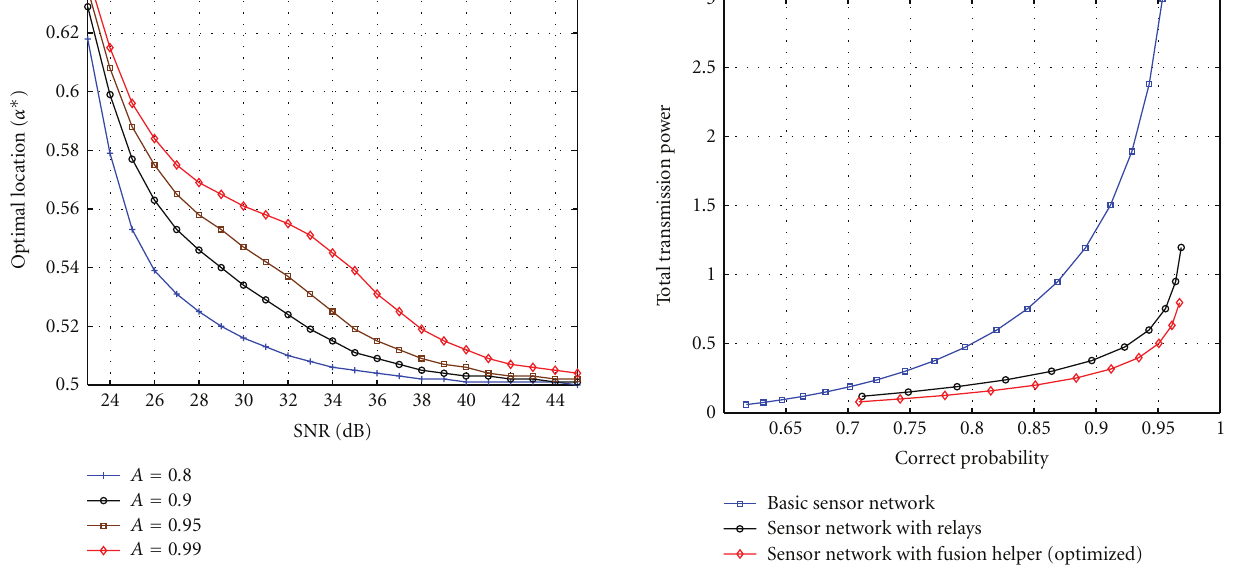
Figure 3: Analytical optimal location of the intermediate fusion helper in Gaussian channels ( β = 3 . 5, d = 10).